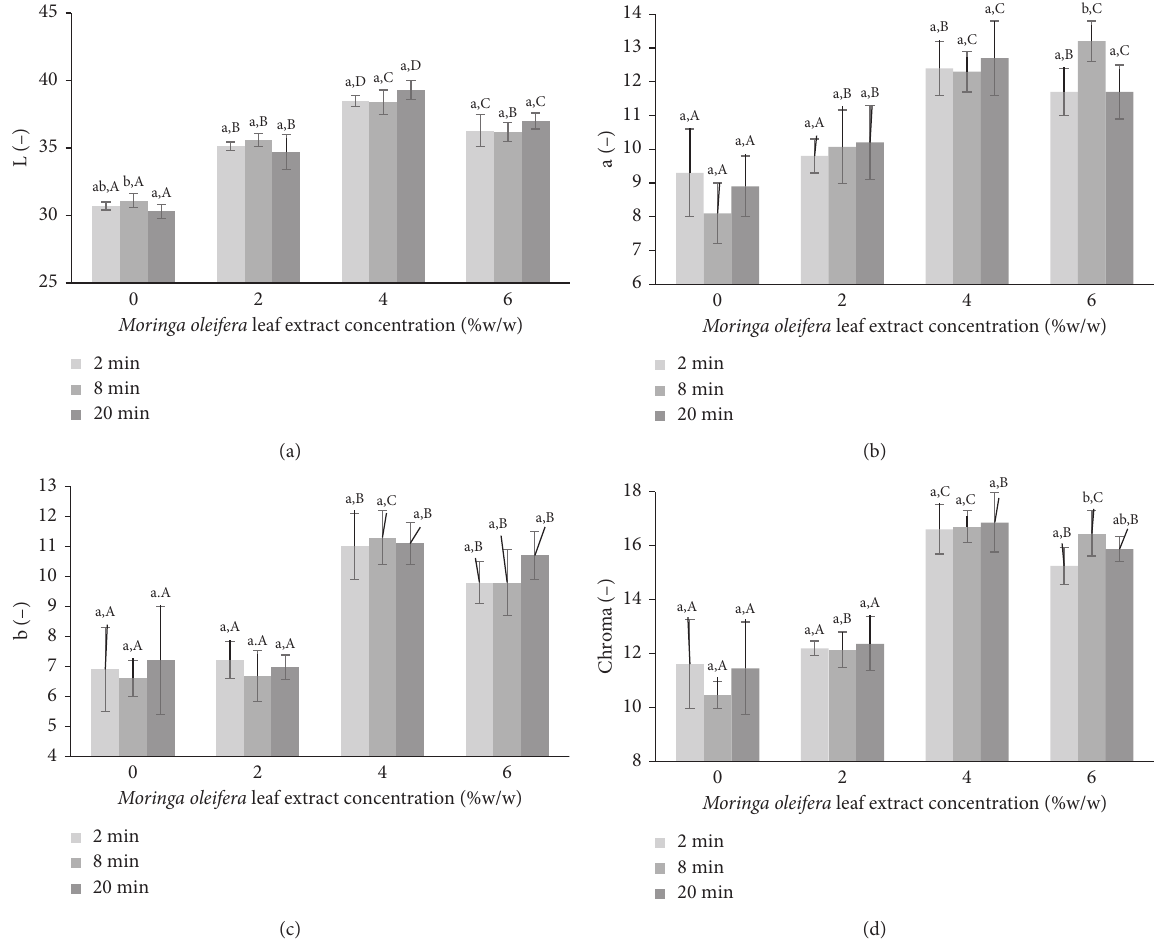
Figure 3: CIE L ∗ , a ∗ , and b ∗ and chroma color properties of chocolate alginate beads as affected by MLE concentration (0, 2, 4, and 6% w/w) and hardening time (2, 8, and 20 min). Different small letters indicate significant differences among samples of the same concentration, while different capital letters indicate significant differences among samples of the same hardening time at p < 0 . 05.